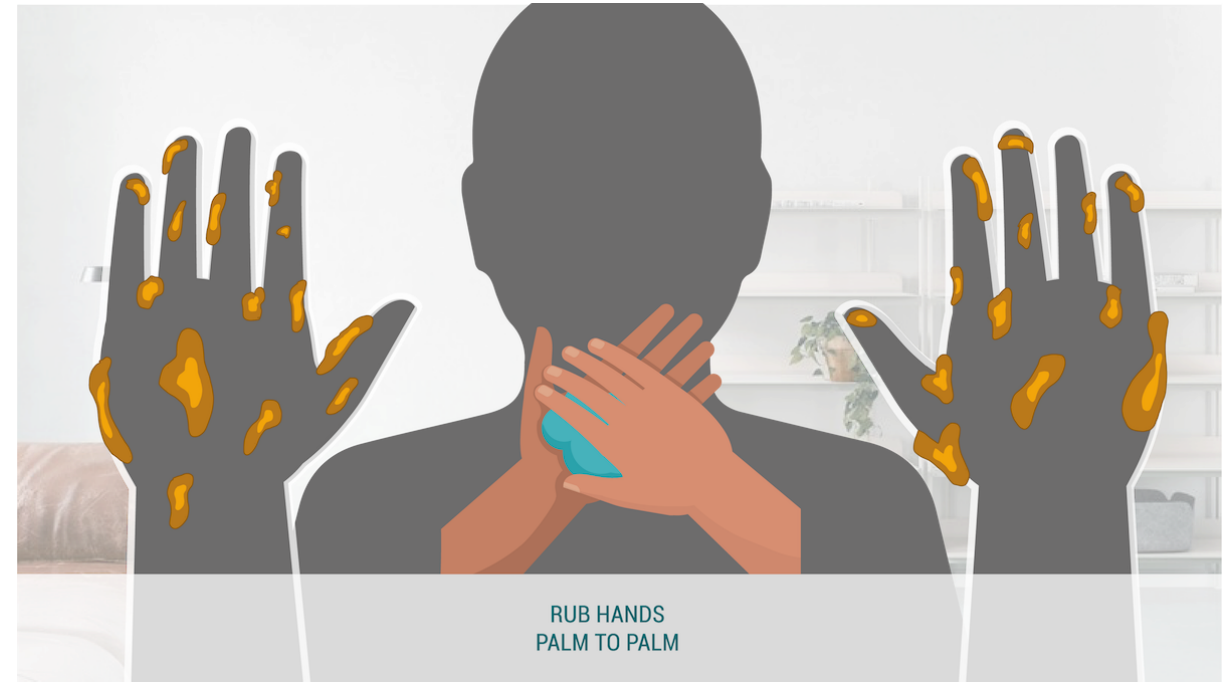
Figure 7. Self-focus augmented reality × reinforcement condition.